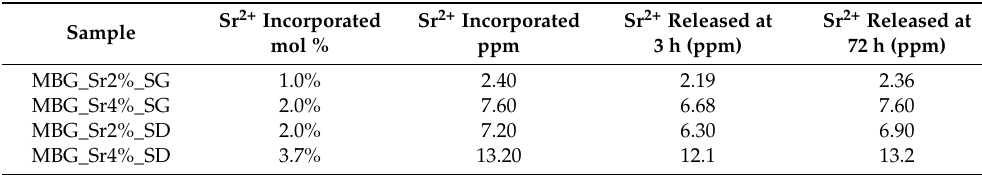
Table 4. Sr 2+ amount incorporated expressed in mol % and ppm, Sr 2+ released quantity in ppm after 3 h and 72 h of soaking in Tris